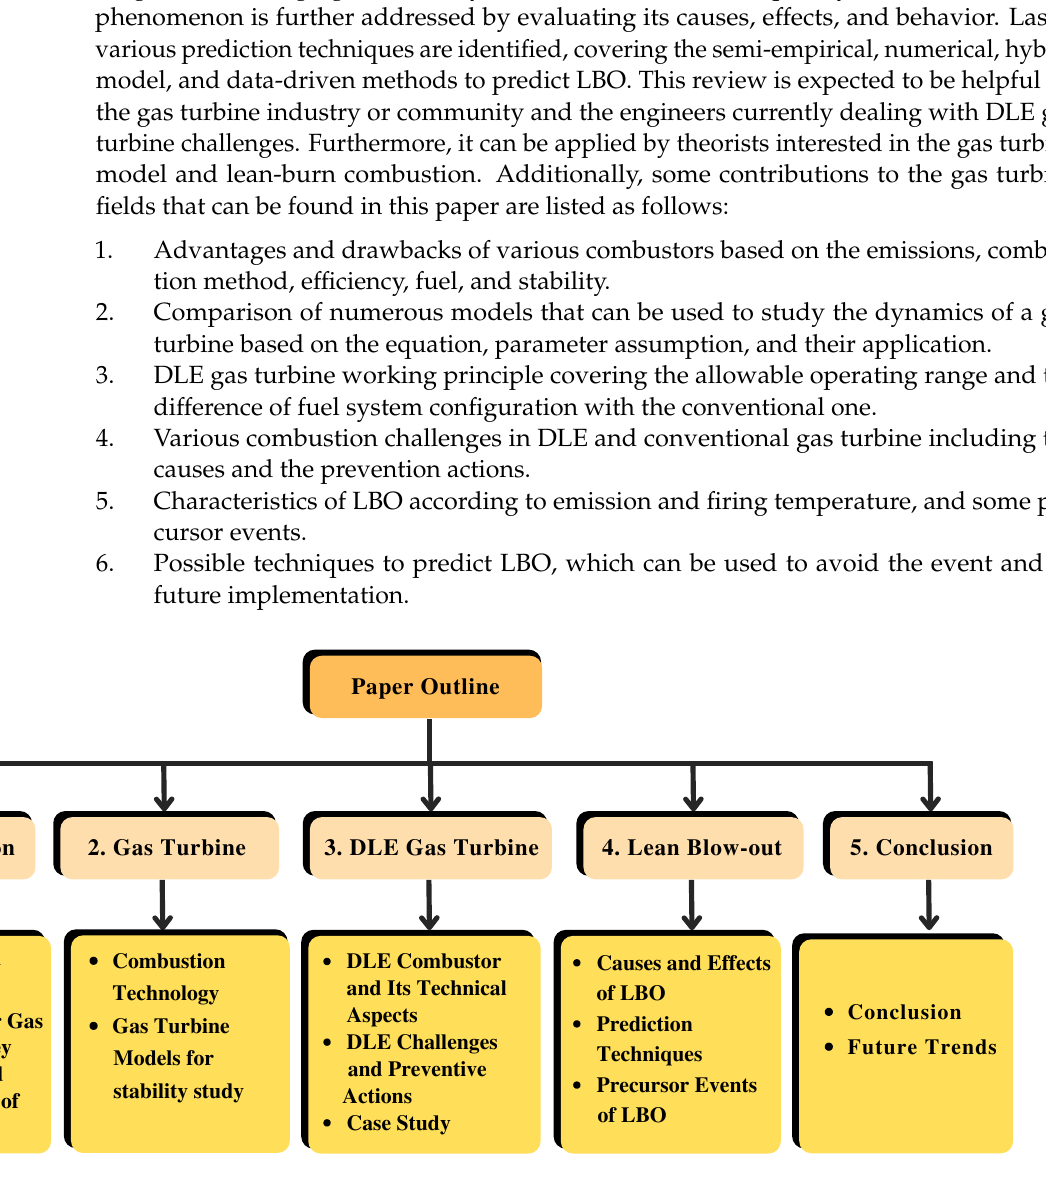
Figure 4. Outline of